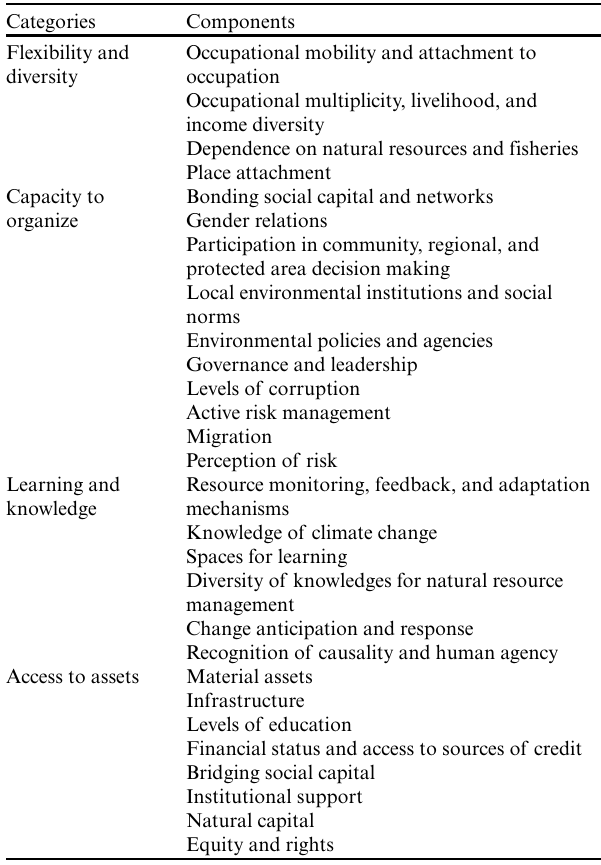
Table 1 . Categories and components of adaptive capacity (after Folke et al. 2003, Marschke and Berkes 2006, Cinner et al. 2009, McClanahan et al. 2009, Marshall et al. 2010).